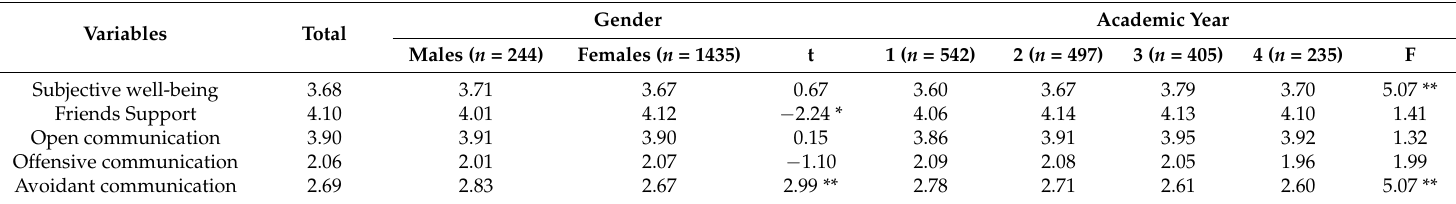
Table 1. Differences in subjective well-being, social support from friends, and family communication per gender and academic year.